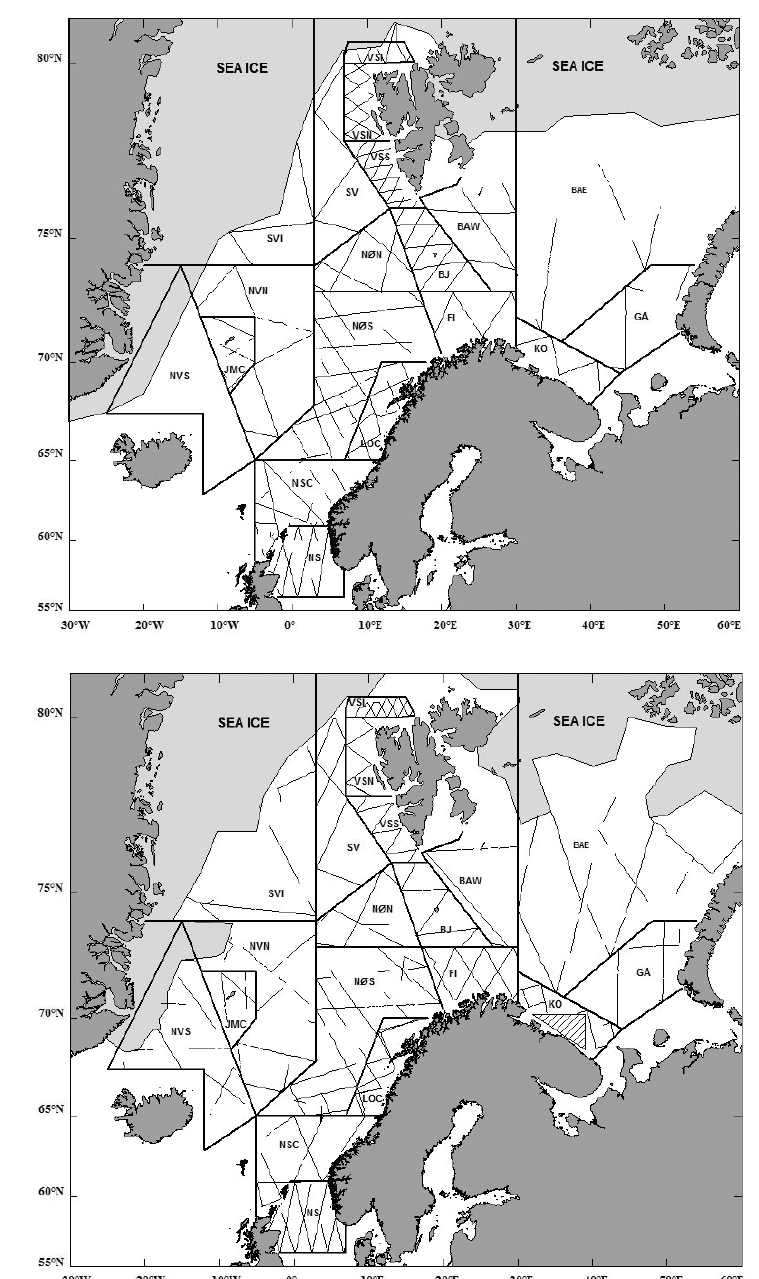
Fig. 1. Survey blocks and realised primary search effort on predetermined transect lines during the 1995 (Fig. 1 a) and 1996-2001 (Fig. 1 b) sightings surveys. The block NVS to the north and east of Iceland did not receive any coverage during the 1995